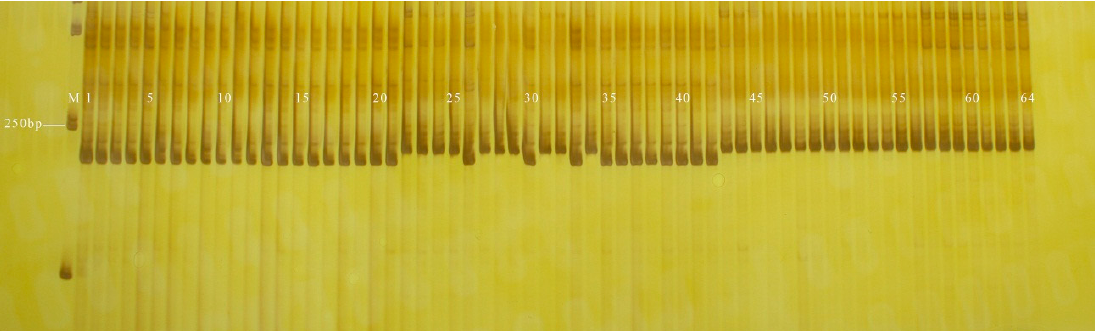
Figure 3. Amplification results of GX7 in some inbred line materials. M: DL2000 DNA Marker; 1–